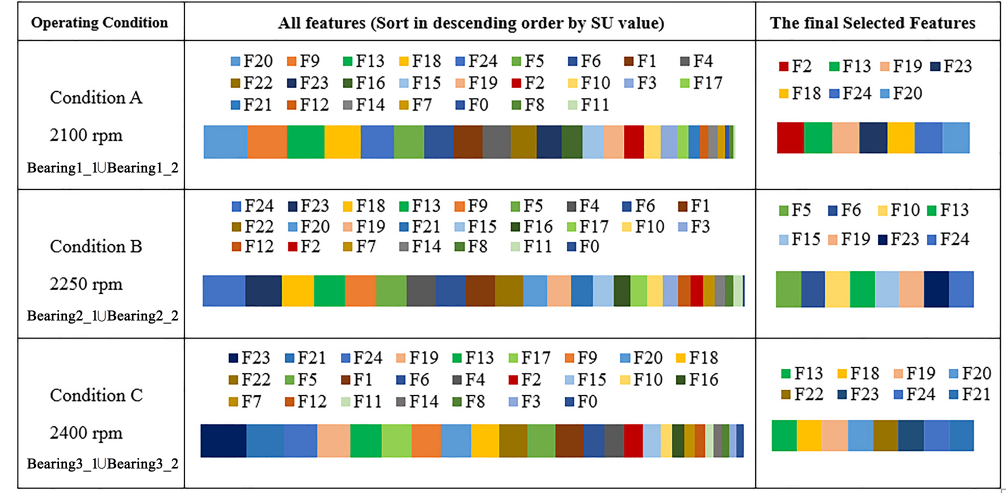
Figure 11. Features selected by the proposed